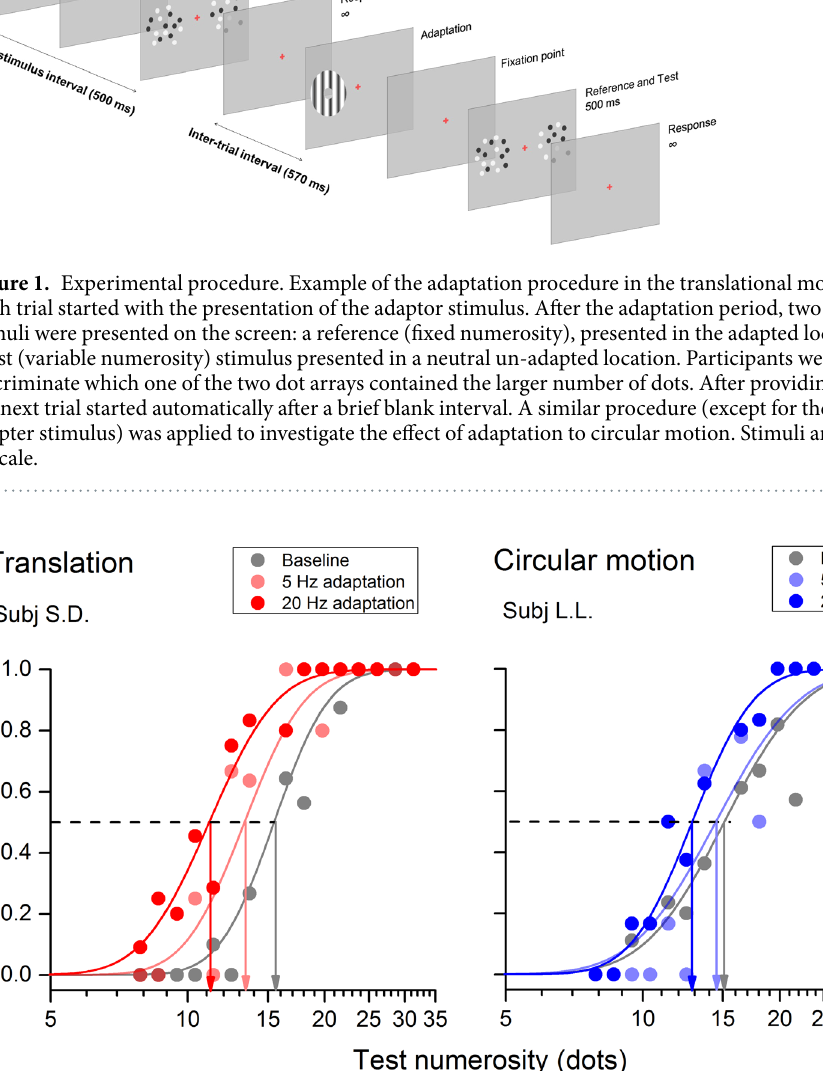
perceived numerosity but to a lesser extent. A sustained exposure to fast circular motion reduced perceived numerosity by about 17%, while slow circular motion (5 Hz) provided a compression similar to that achieved for slow translational motion (around 12%). A series of paired-sample t-test showed that post-adaptation PSEs were significantly lower compared to baseline measures, in all the adaptation conditions taken into account: trans- lation 5 Hz (t (13) = 3.97, p < 0.001), translation 20 Hz (t (13) = 8.92, p < 0.001), circular motion 5 Hz (t (13) = 3.92, p < 0.001); circular motion 20 Hz (t (13) = 4.23, p < 0.001). Furthermore, the magnitude of the effects across